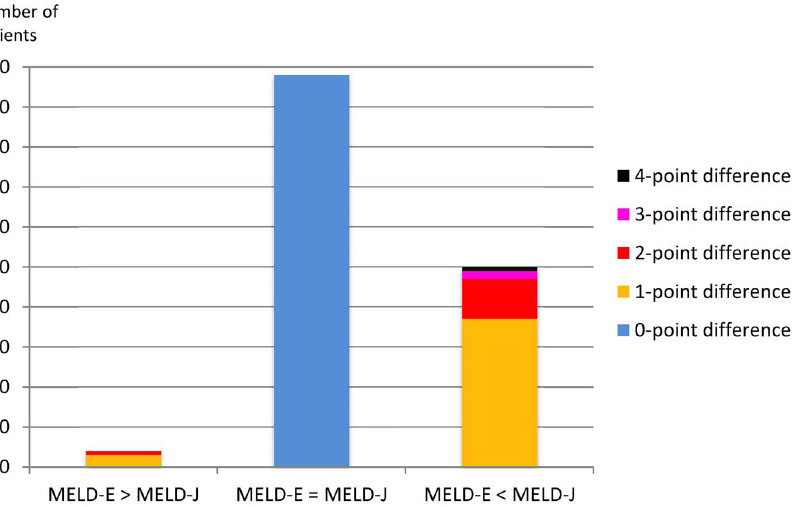
Figure 4. A comparison of the creatinine measurements that were obtained enzymatically (MELD-E) and according to the Jaffe´ method (MELD-J) for samples with MELD scores . 20. Overall, 152/1,013 (15.0%) samples met this condition.